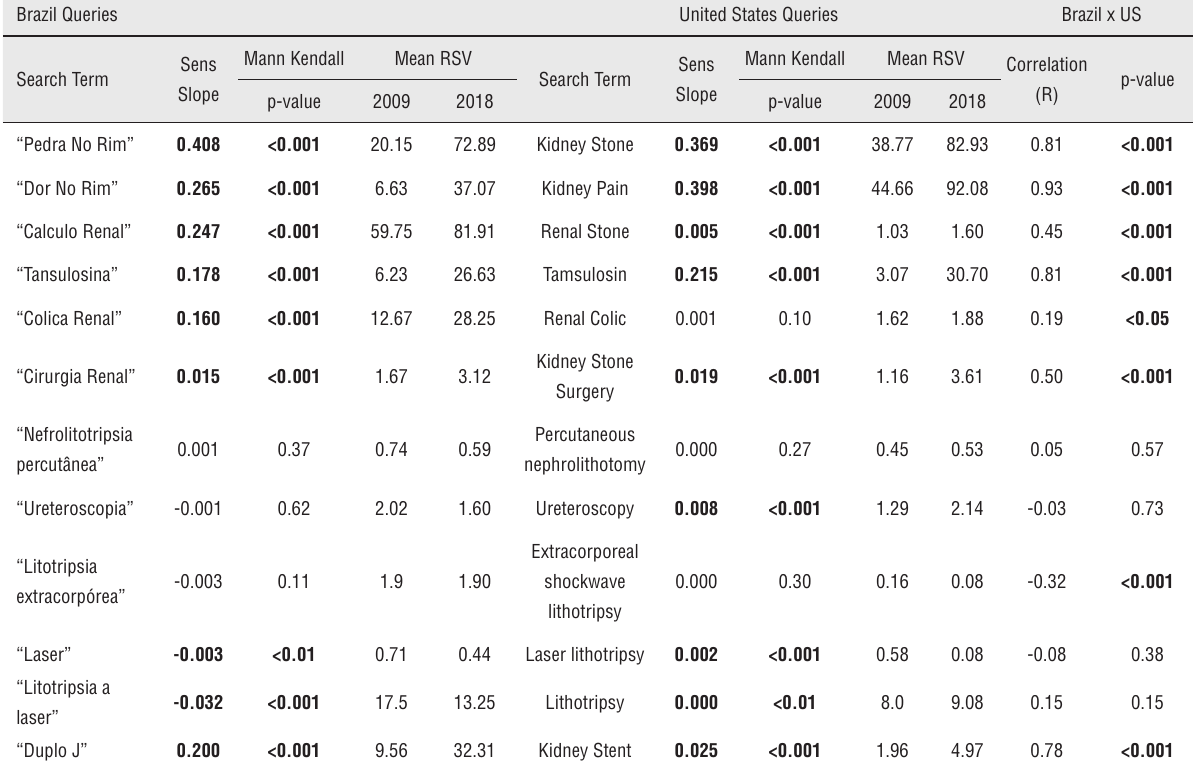
Table 1 - Total Relative Search Volume (RSV) in United States (US) and Brazil in 2009 and 2018, trend variation measured by Mann Kendall Sen’s Slope (SS) Estimator, and term correlation between (R) countries. Brazil